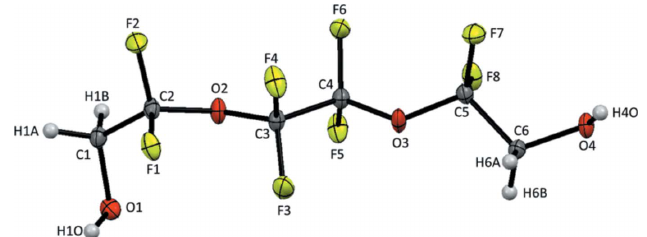
Table 2 Experimental details.